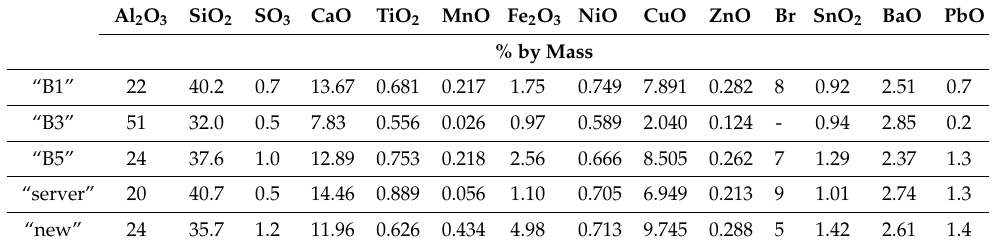
Table 1. Chemical compositions (as oxides) of the initial materials after PCB scraps grinding and separation.